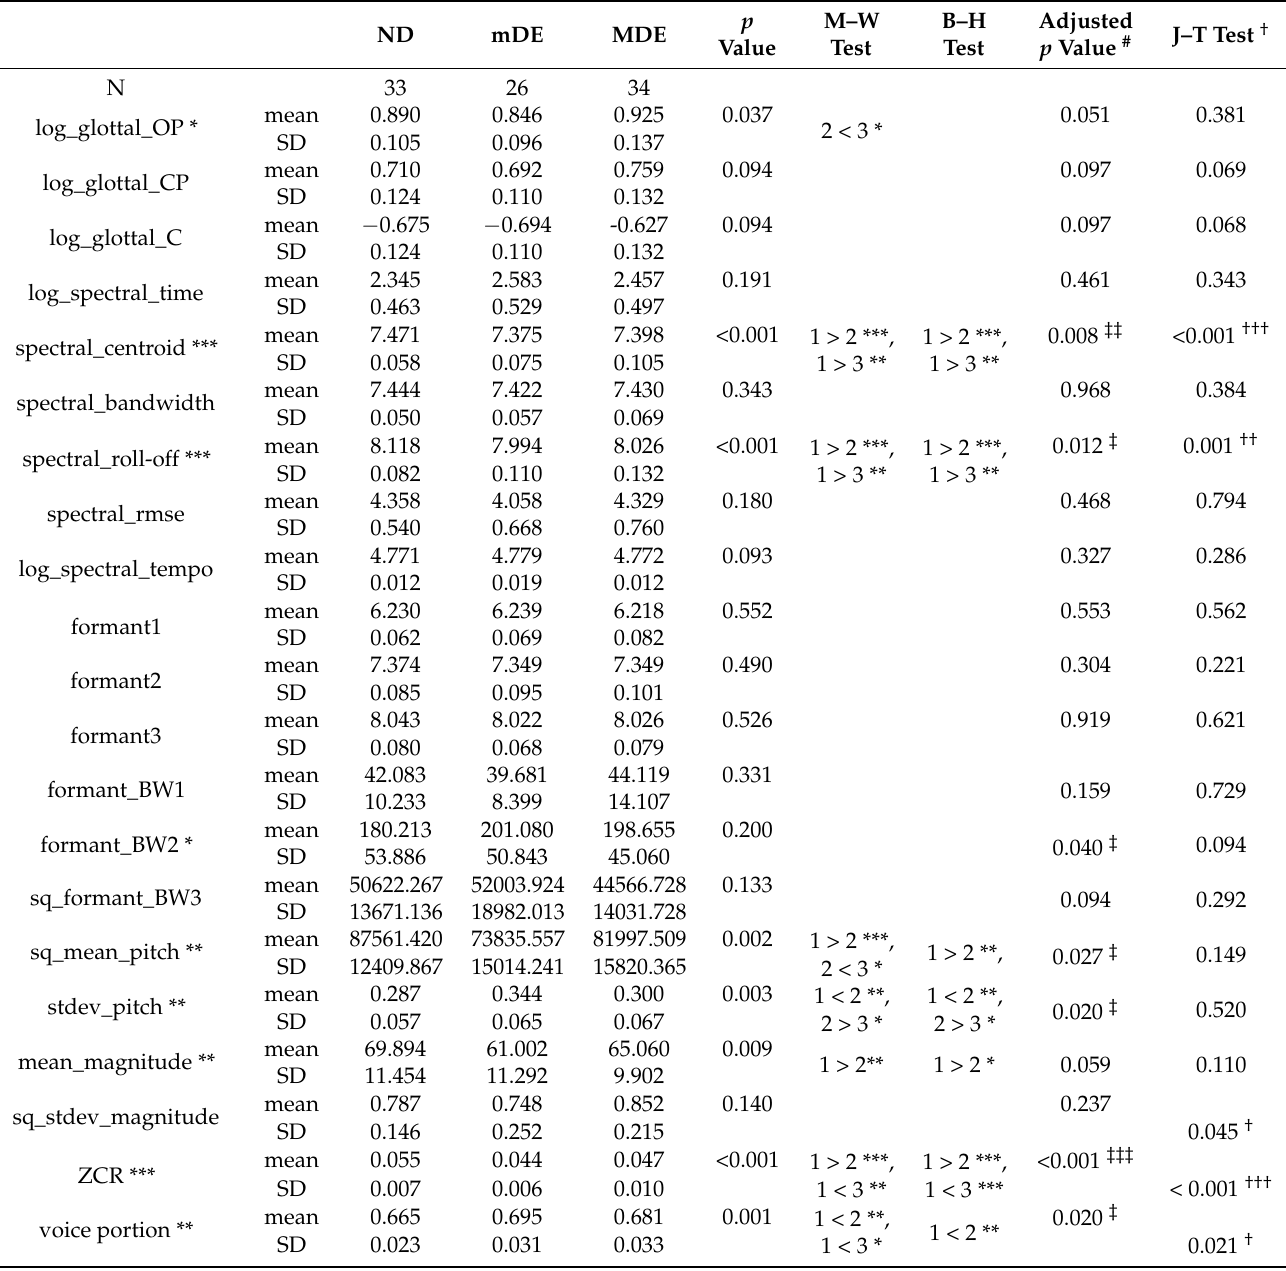
Table 3. Difference of voice features by depressive